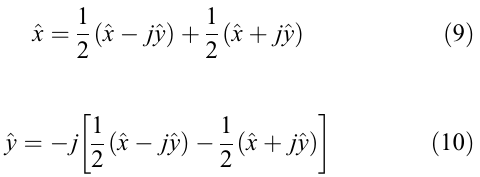
Figure 10. Incident plane wave has a magnitude of ffiffiffi 2 E-field on the Y - Z plane.